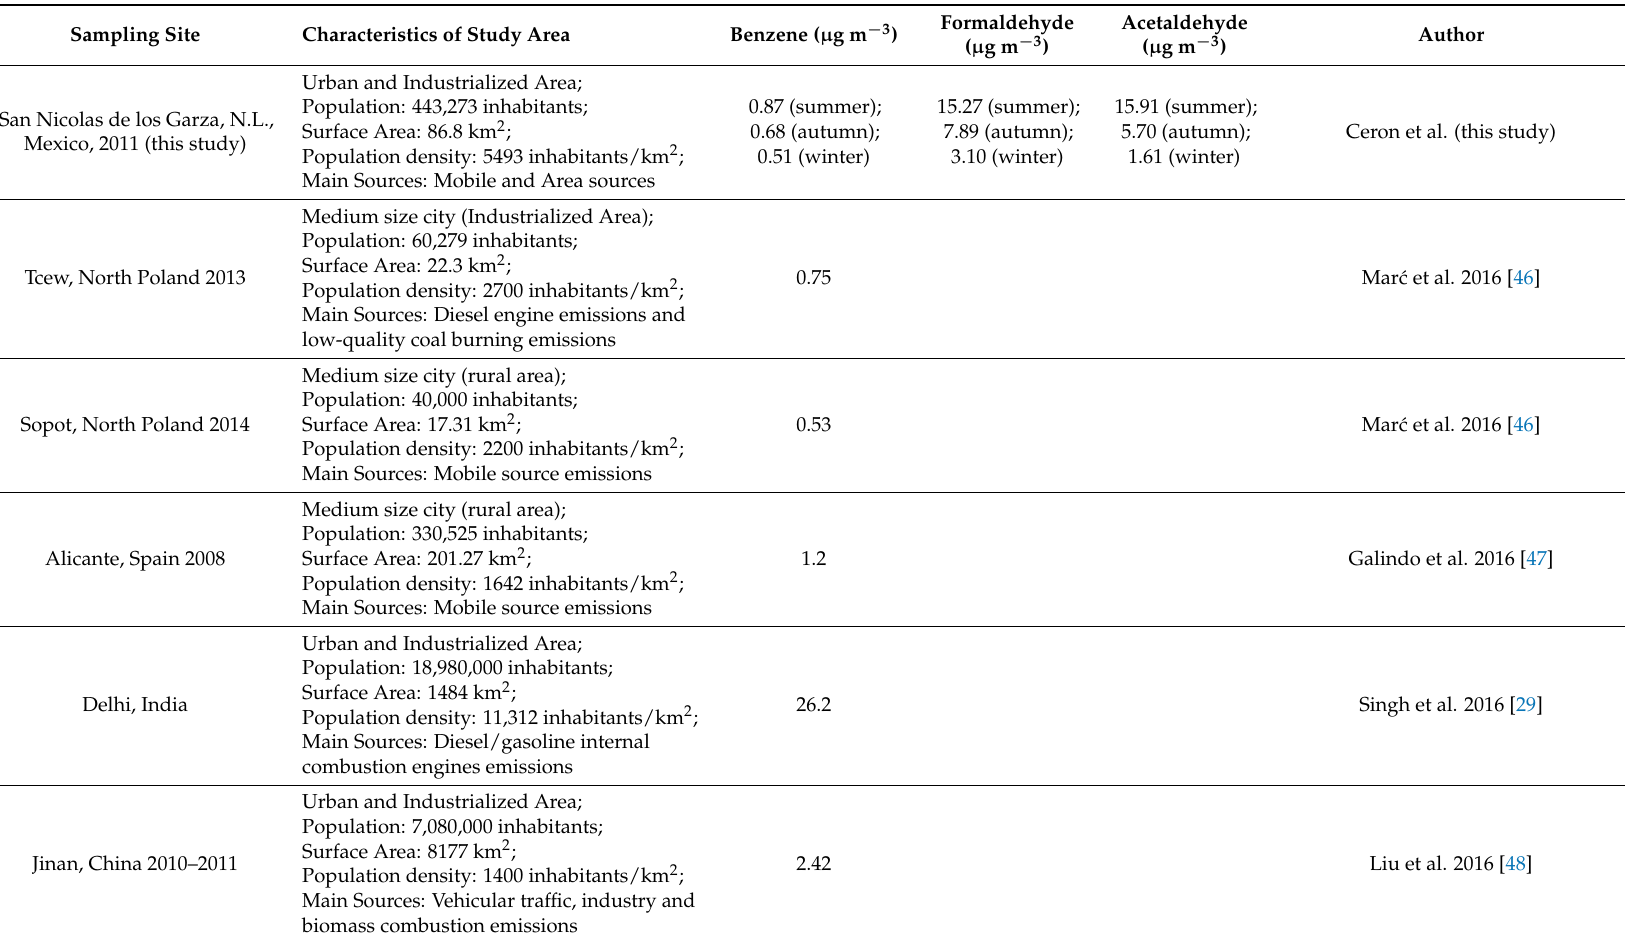
Table 2. Comparison of average concentrations of measured VOCs in this study (benzene, formaldehyde, and acetaldehyde) with results found in other studies around the